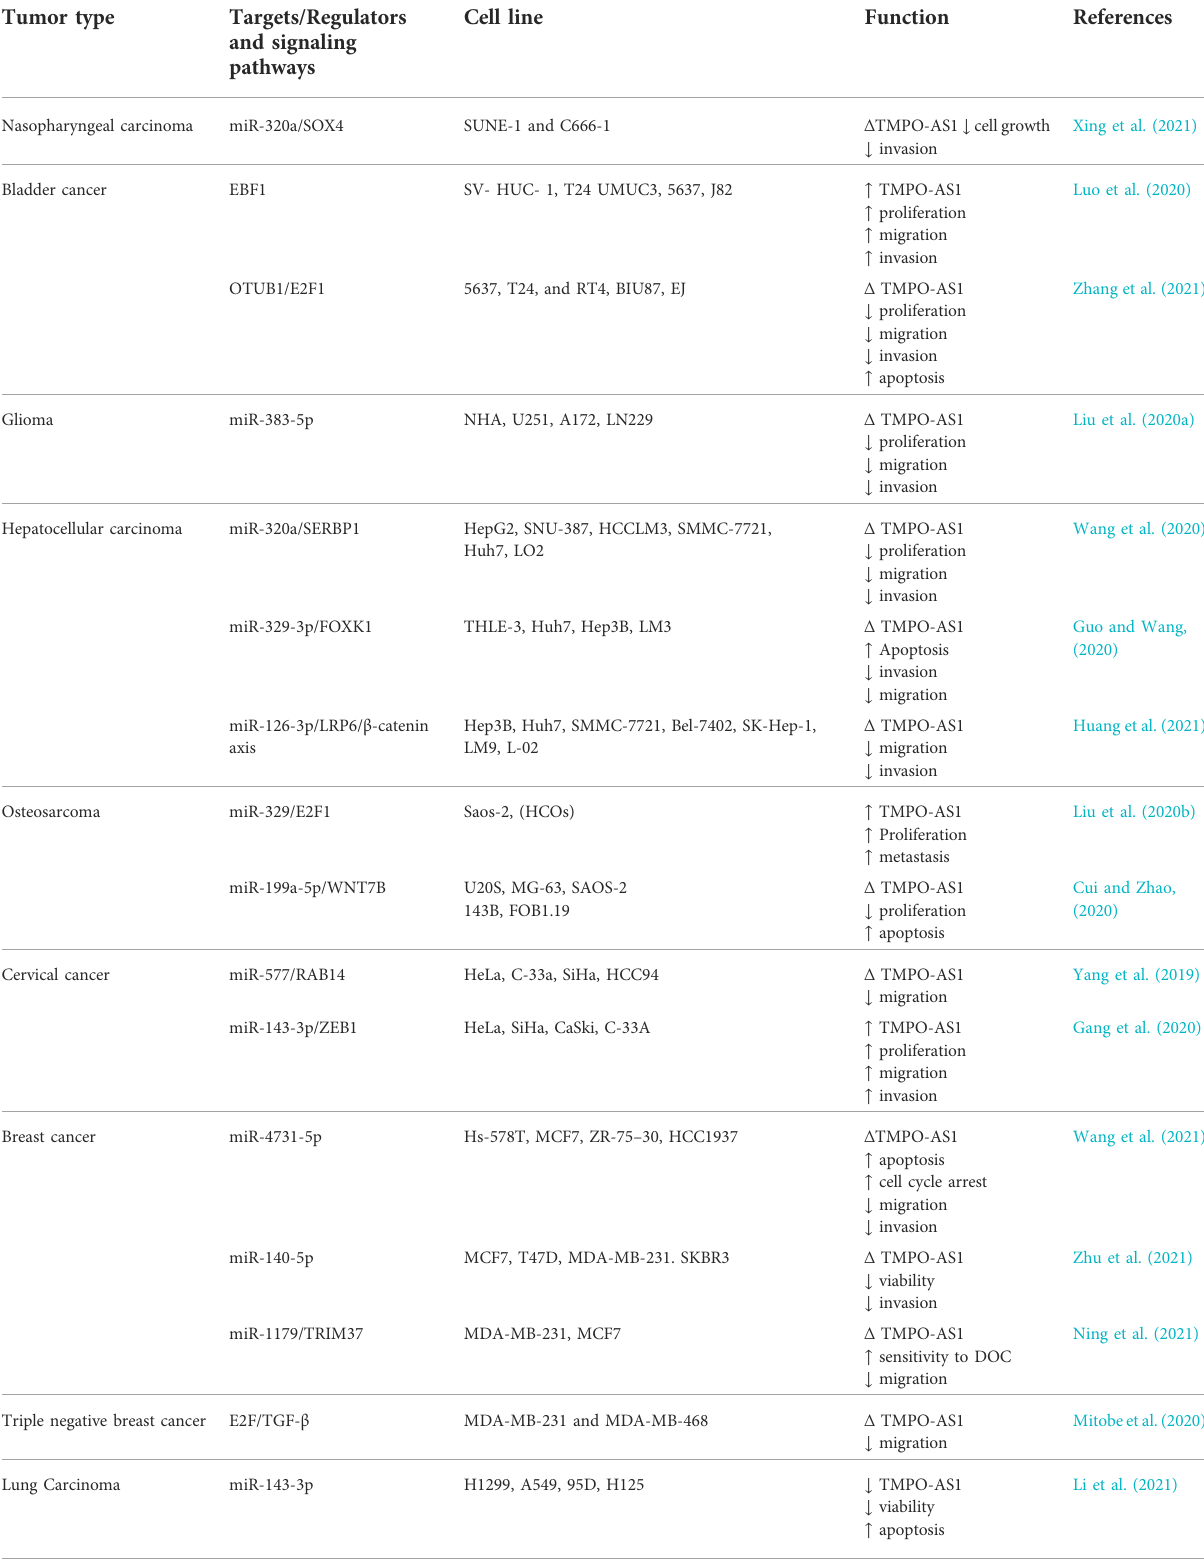
TABLE 1 Expression pattern of TMPO-AS1 in cancer cell lines ( Δ : knock-down or deletion, DOC: